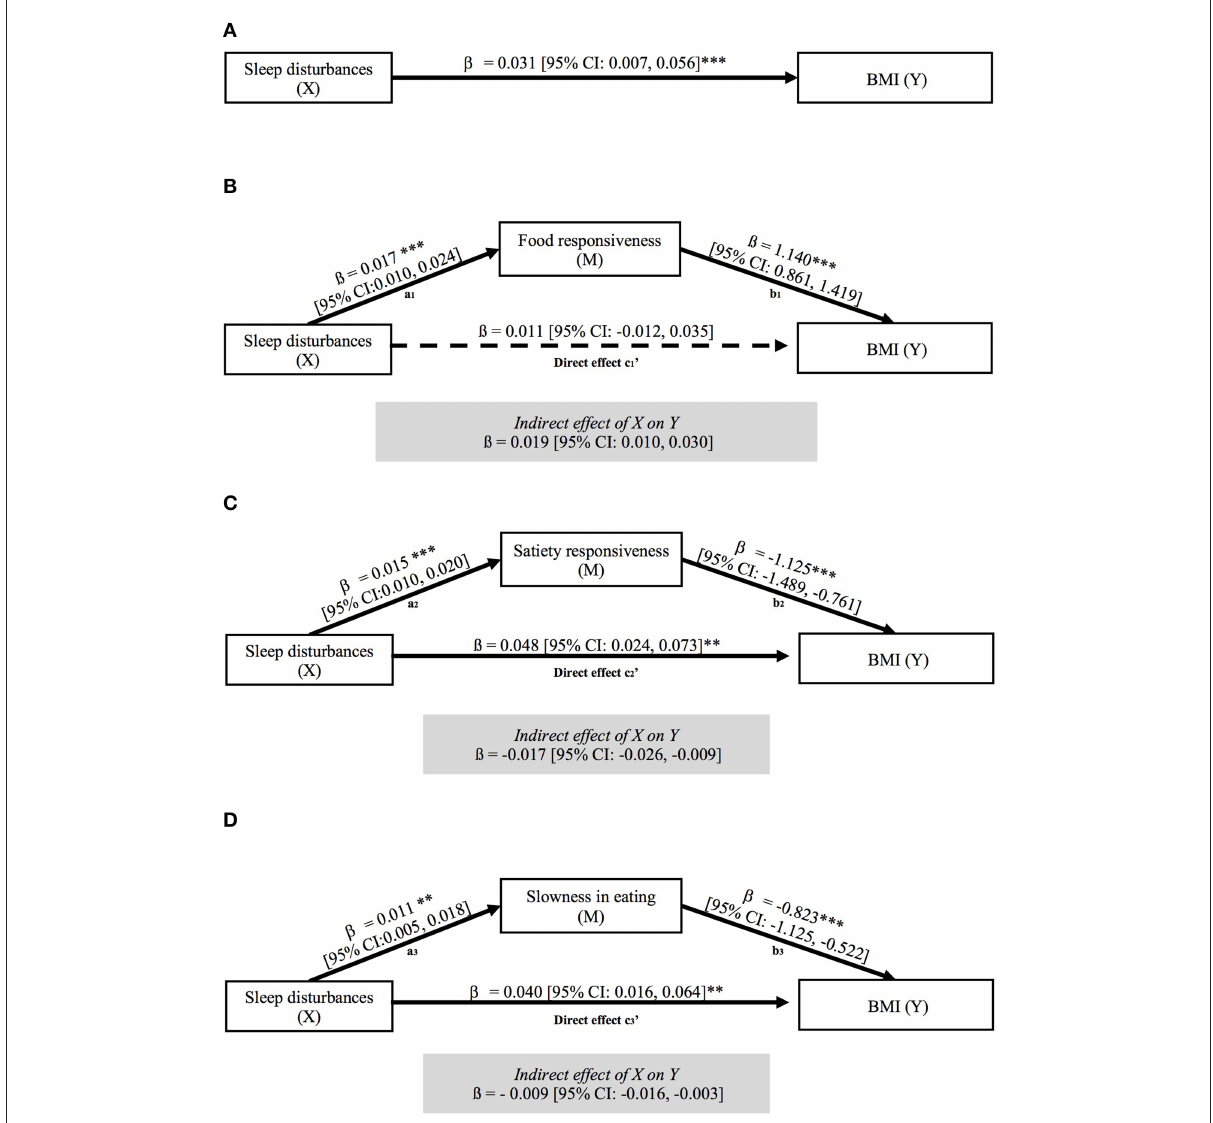
FIGURE2 Mediation model highlighting the effect of sleep disturbances on BMI via food responsiveness, satiety responsiveness and slowness in eating. Figure (A) shows the direct effect of sleep disturbances on BMI, while the remaining figures show the effect of sleep disturbances on BMI via food responsiveness (B) , satiety responsiveness (C) and slowness in eating (D) . All models were adjusted for age, gender, and physical activity. Results are shown as unstandardized β coefficient represents with their 95% CI. Solid lines indicate statistically significant paths, while